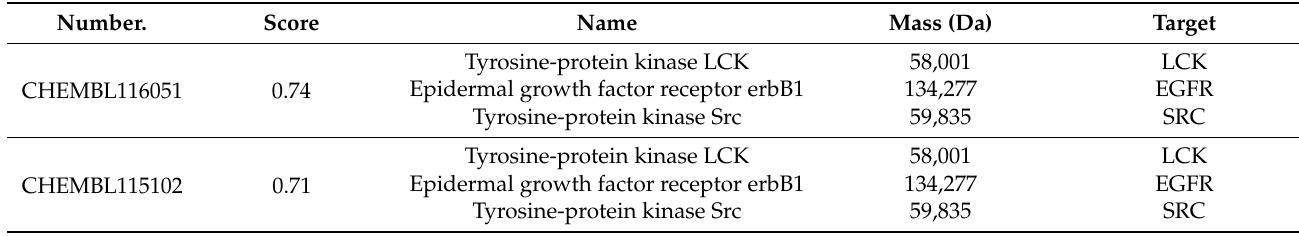
Table 2. Target candidates of Kae identified by TargetHunter.